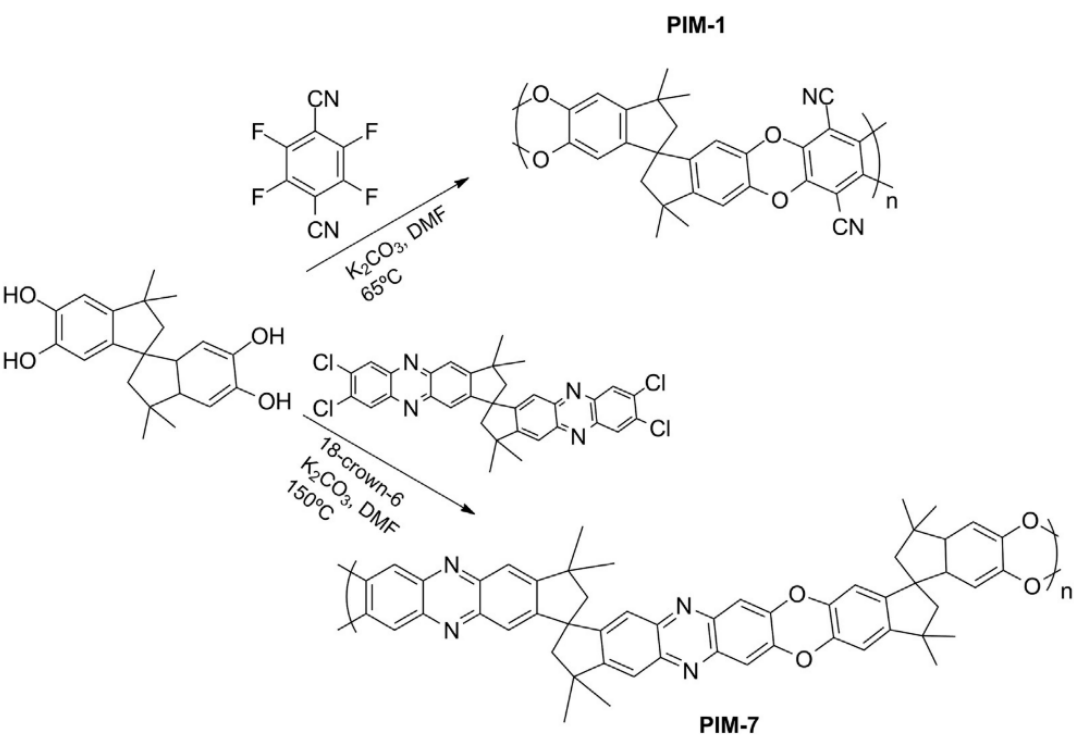
Figure 15. Synthesis and chemical structures of PIM-1 and PIM-7 [23].